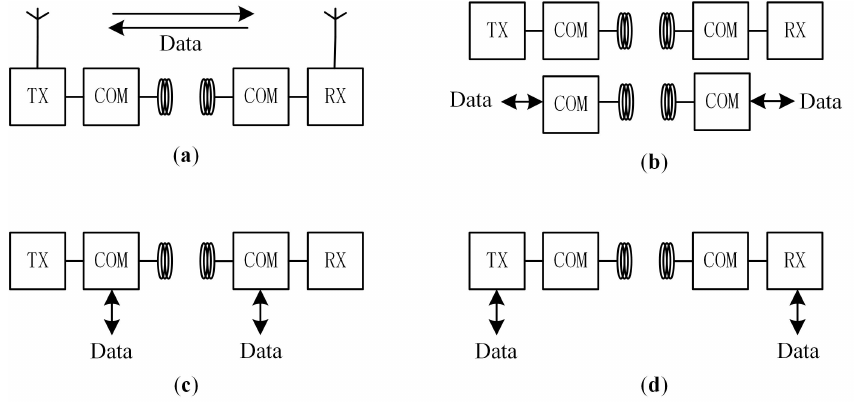
Figure 1. Diagram of four basic methods for bidirectional communication. ( a ) Radio frequency link. ( b ) Additional communication coils. ( c ) Coupling with compensation circuit. ( d ) Modulating with power